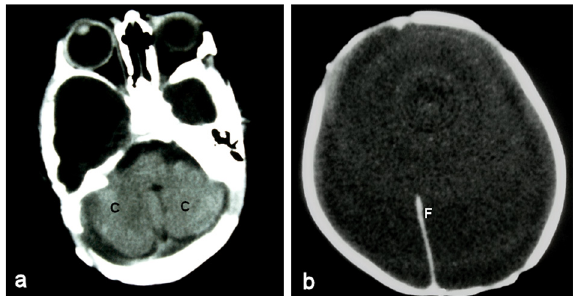
Figure 4. CT images of 2 days old newborns brain. ( a ) Intact Cerebellum (C) and other posterior fossa structures. ( b ) Shows disrupted falx cerebri